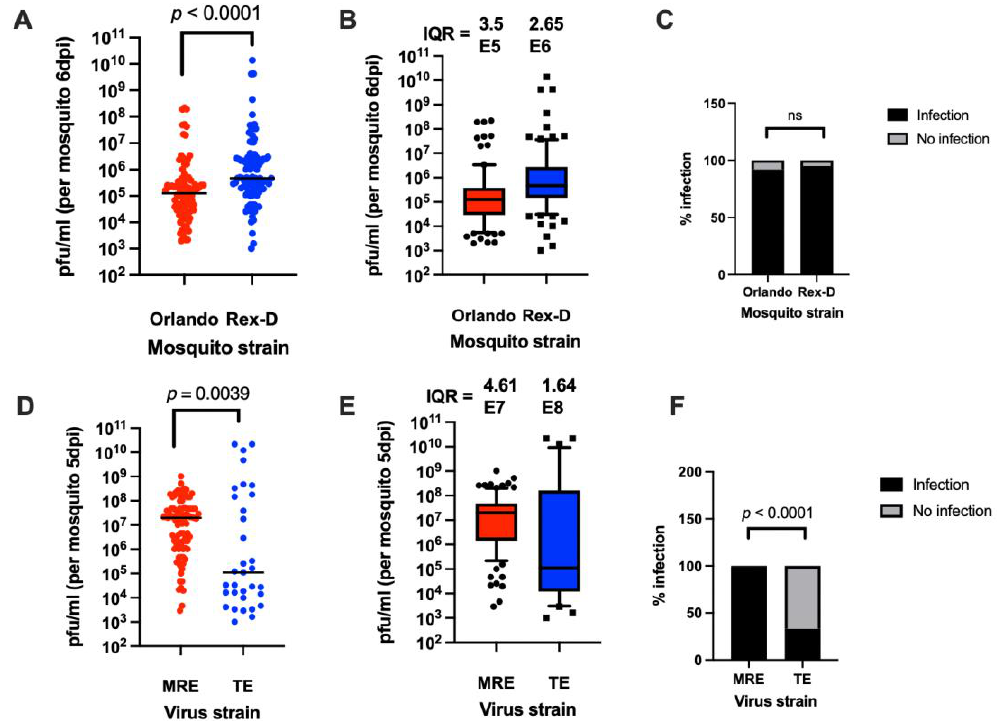
Figure 3. Oral infection of Ae. aegypti using either different mosquito strains or SINV strains. ( A ) Titers of Orlando and Rex-D mosquitoes at 5 days after feeding on a blood meal containing MRE-16. ( B ) The use of IQR as a measure of variation. The dataset used in panel B is the same as in ( A ). ( C ) Prevalence of infection of different mosquito strains after oral infection. ( D ) Titers of mosquitoes at 5 days PBM that were infected with MRE-16 or TE. ( E ) The use of IQR as a measure of variation. The dataset used in panel ( E ) is the same as ( D ). ( F ) Prevalence of infection after oral infection with different viral strains. Sample size was 100 for MRE and 33 for TE. Statistical analysis was performed as described for Figure 1. Fisher’s exact test was used for statistical analysis in ( C , F ).